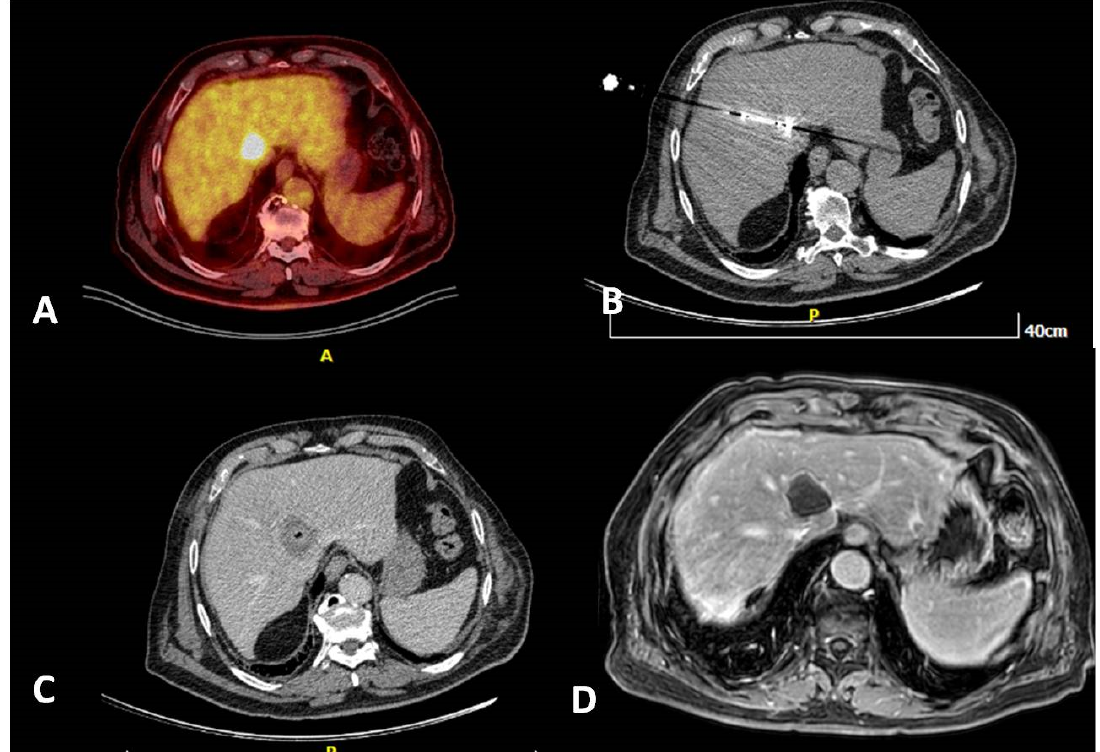
Figure 3. A 80-year-old, male patient with a medical record of colorectal cancer (operated) and a solitary PET avid liver metastasis right next to the junction of hepatic veins depicted 6 months post-initial diagnosis ( A ). Due to lesion location and in agreement with the patient’s will, the tumor board decision was percutaneous microwave ablation, which was performed under computed tomography guidance ( B ). Contrast-enhanced computed tomography scan (portal venous phase) illustrates the zone of necrosis immediately post-ablation ( C ). MRI 6 months post-ablation shows a lack of contrast medium uptake related to a successful ablation session ( D